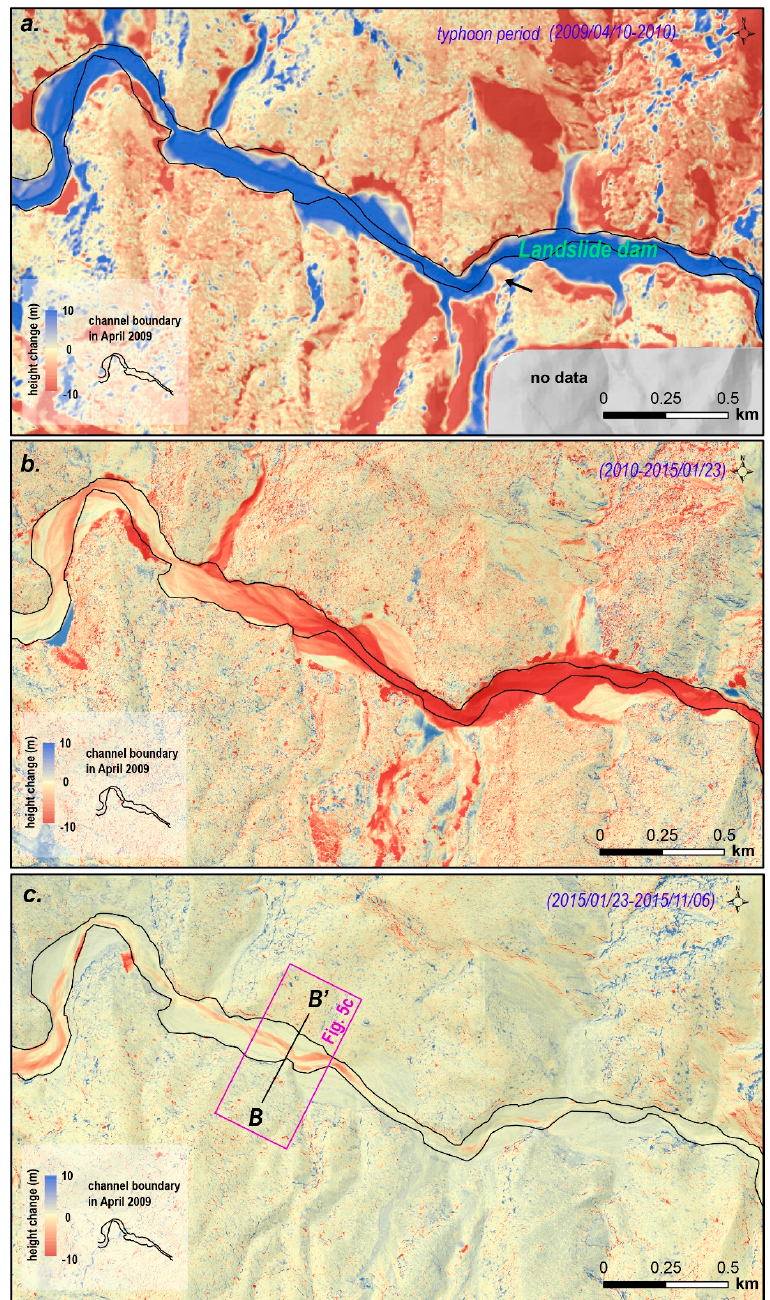
Figure 4. Distribution of height change obtained from the DEM by the UAV survey in a